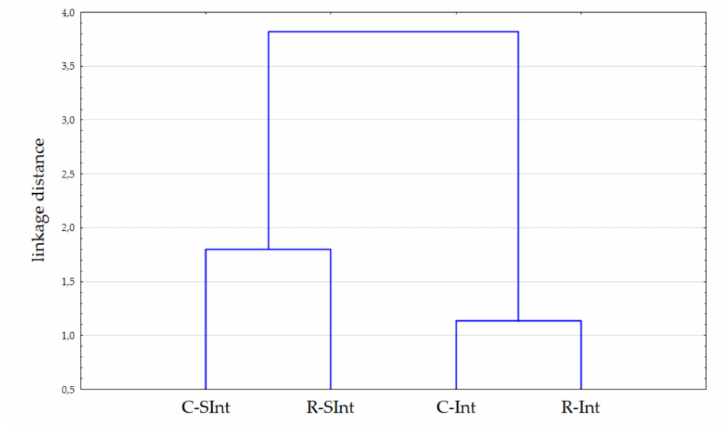
Figure 1. Complete-linkage dendogram for bulls obtained from nurse cow (C) and milk replacer (R) rearing systems fattened intensively (Int) or semi-intensively (SInt) based on fat content, WBSF, the proportion of conjugated linoleic acid (CLA), eicosapentaenoic acid (EPA), docosapentaenoic acid (DPA), docosahexaenoic acid (DHA), PUFAs, and n -3, n -6/ n -3 ratio, Fe, Zn, α -tocopherol